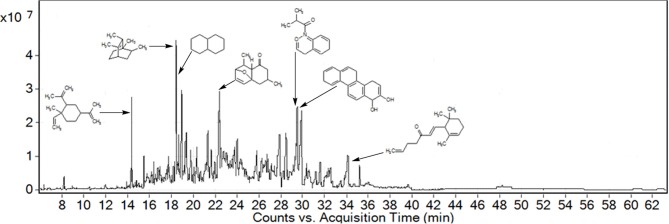
GC-MS chromatogram of Leaf essential oil from Polygonum hydropiper showing major identified compounds.